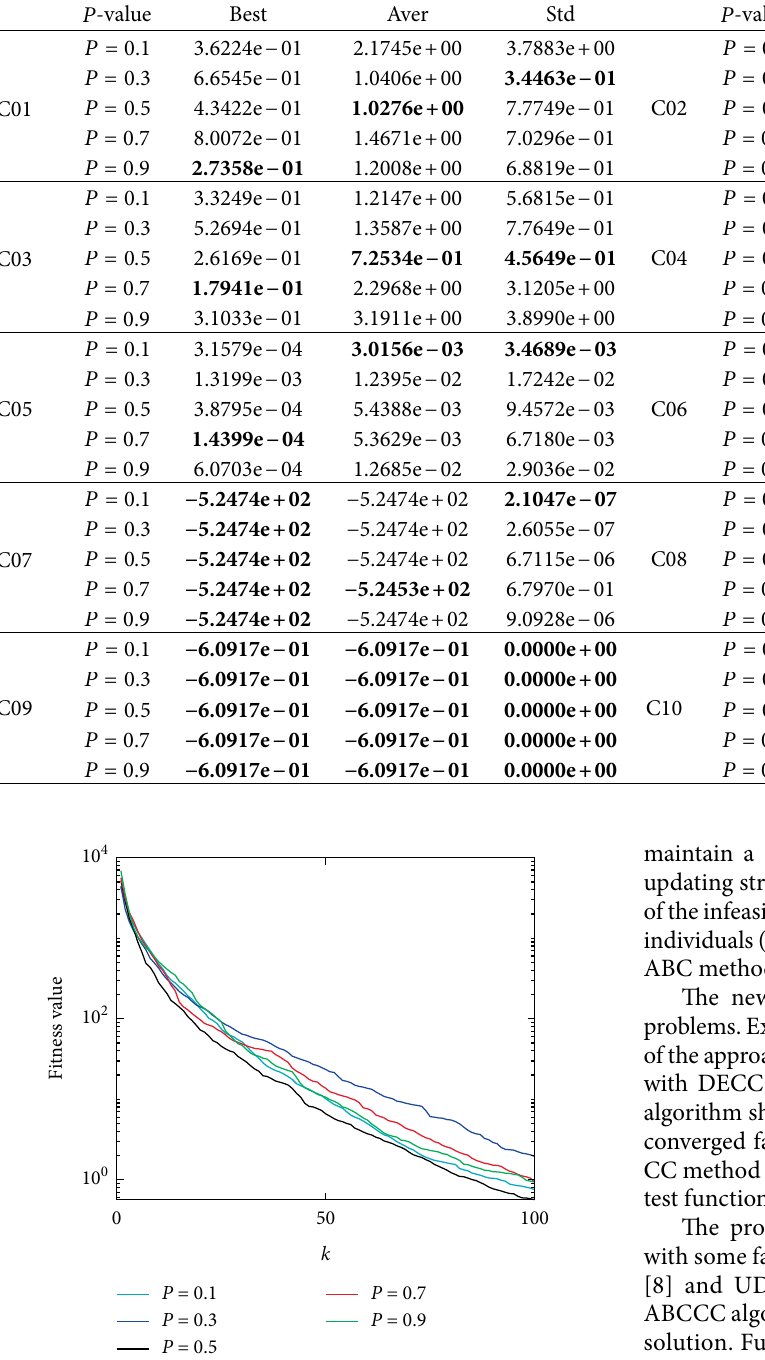
Figure 6: Convergence curves of ABCCC with different values of (C02). 𝑃